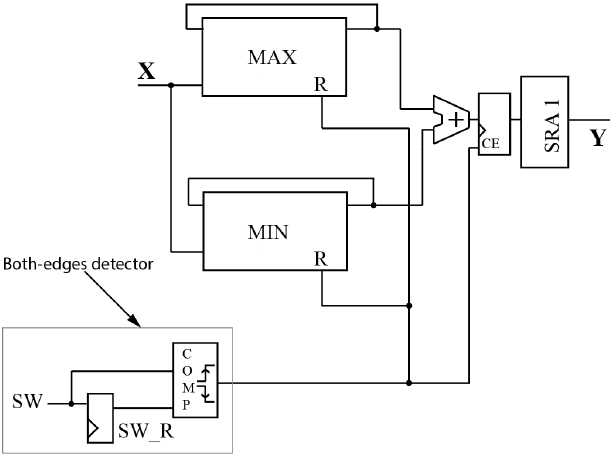
Figure 3. Digital schematic of the maximum-minimum point (MAX-MIN) filter.